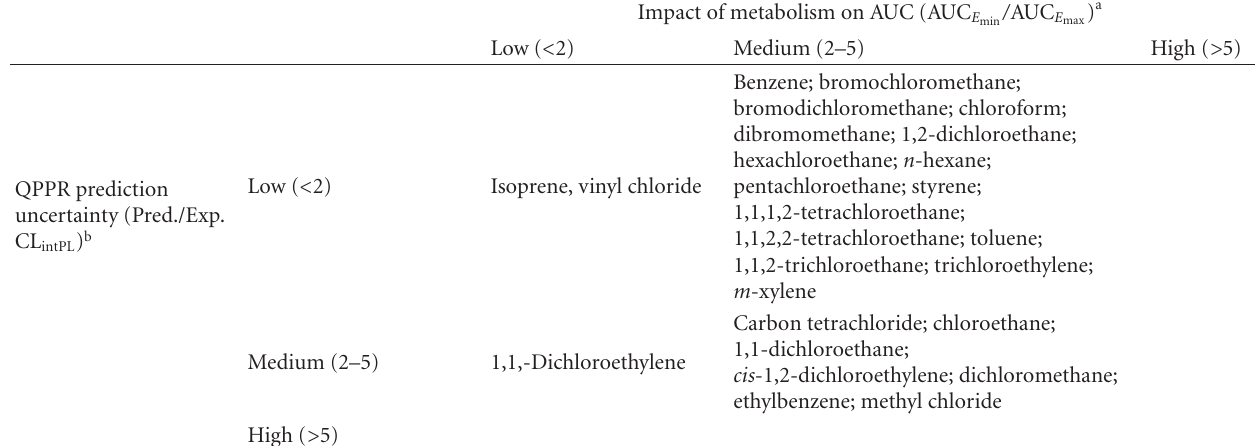
Table 4: Reliability analysis of the QPPR for CL int on the PBPK predicted AUC.